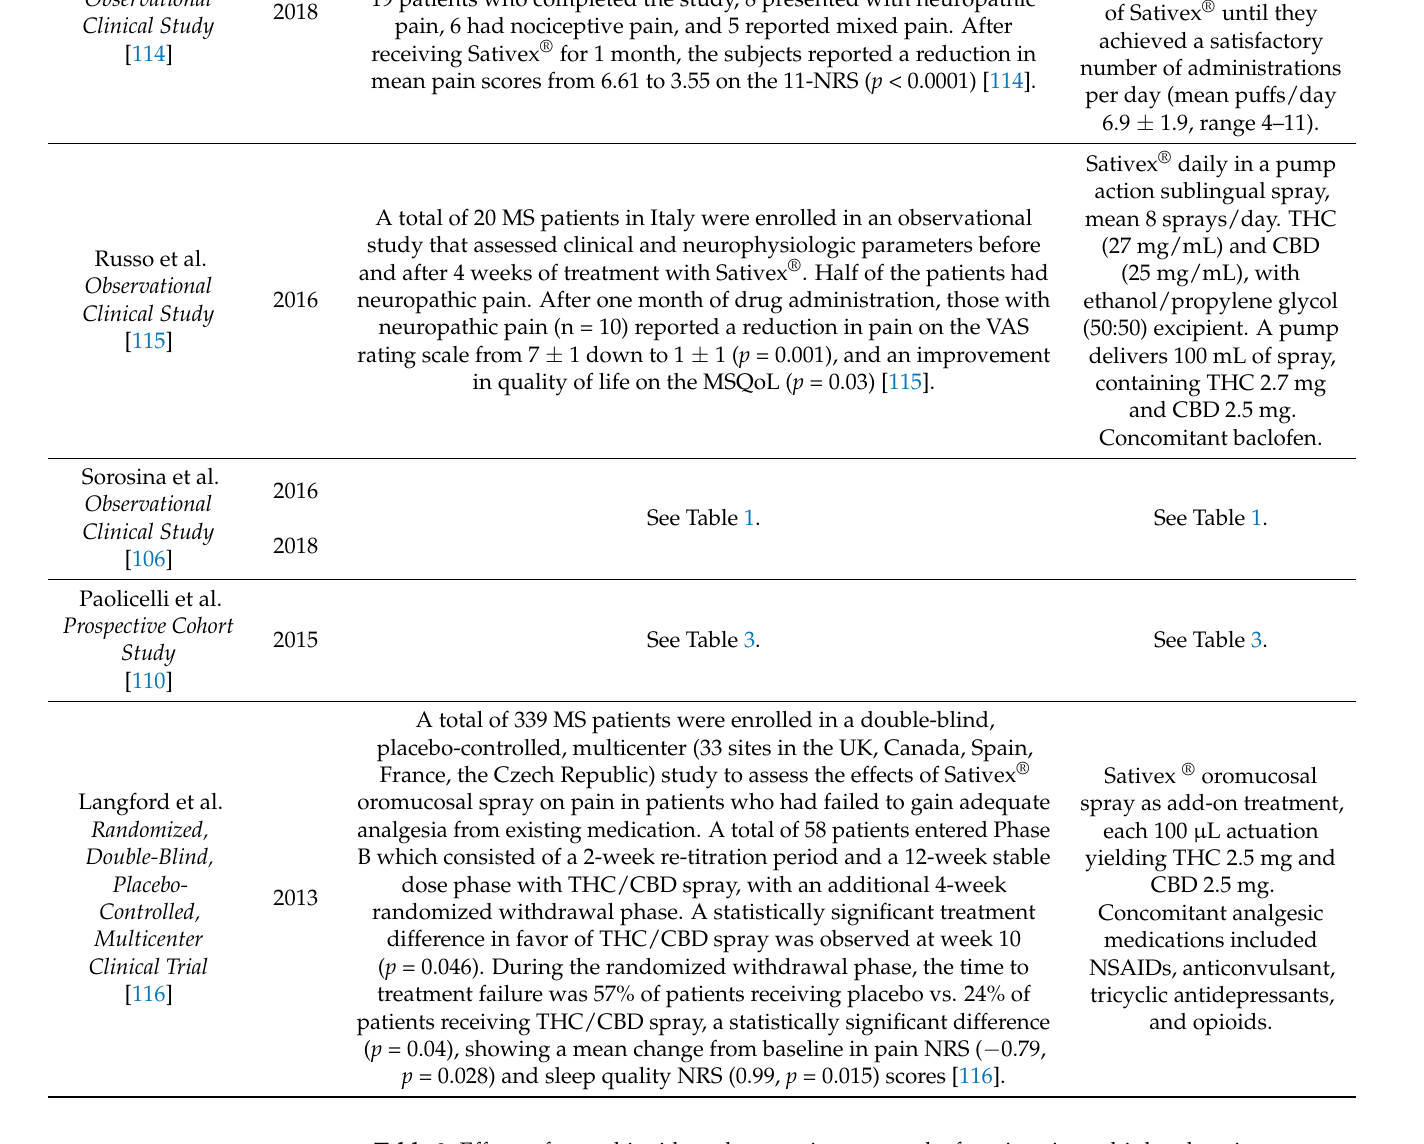
Table 3. Effects of cannabinoids on lower urinary tract dysfunctions in multiple